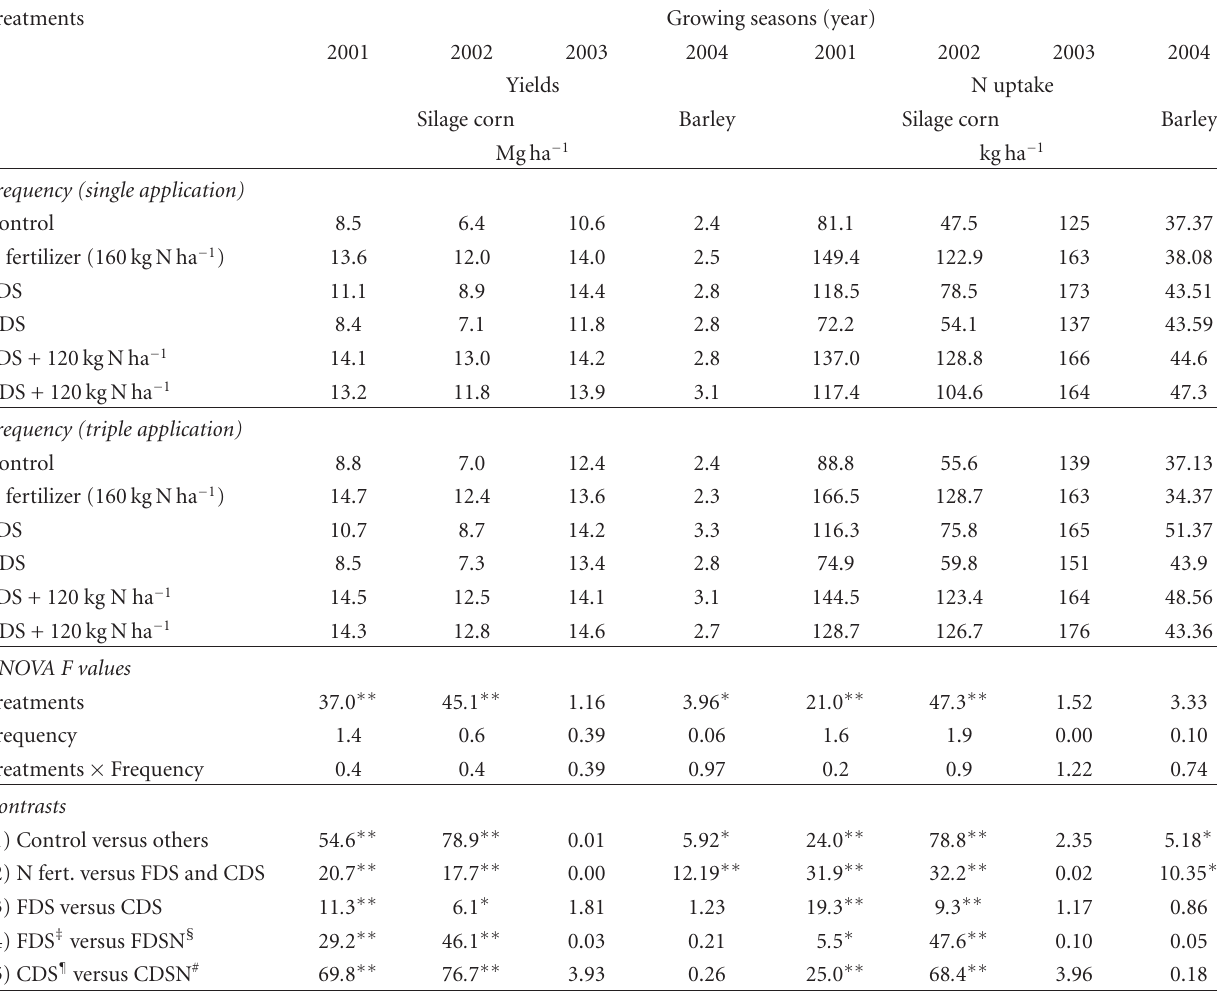
Table 5: Direct and residual e ff ects of applications of fresh and composted paper sludges, and N fertilizer on yield and N uptake of silage corn (2001 to 2003) and barley